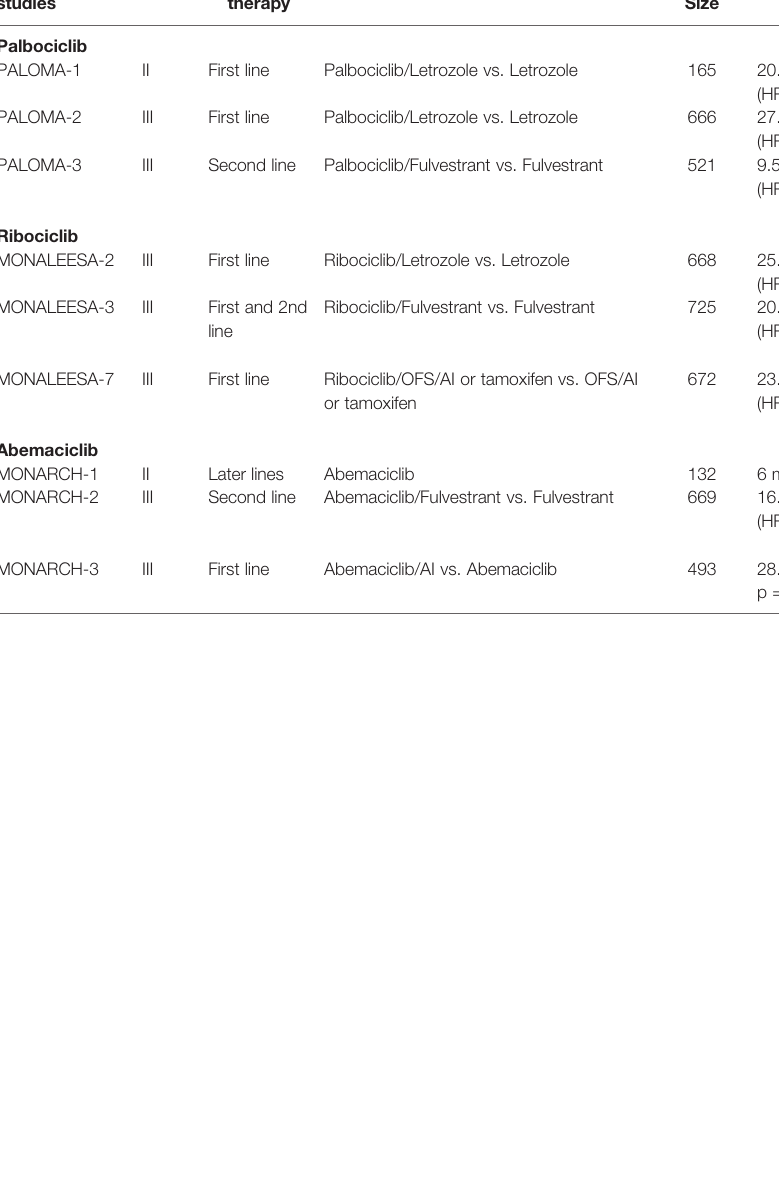
TABLE 3 | Overview of the clinical trials for the approved CDK4/6 inhibitors in the metastatic setting. Name of the